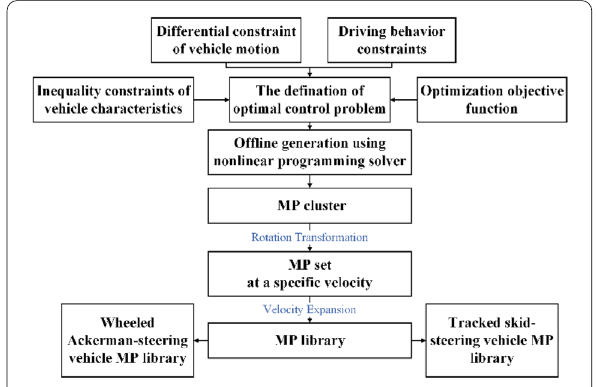
Figure 1 MP offline generation algorithm